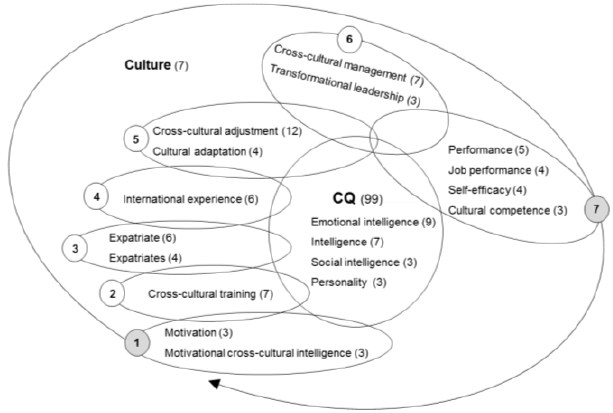
Figure 1: Concepts associated with CQ (figures in brackets represent the number of times the key word